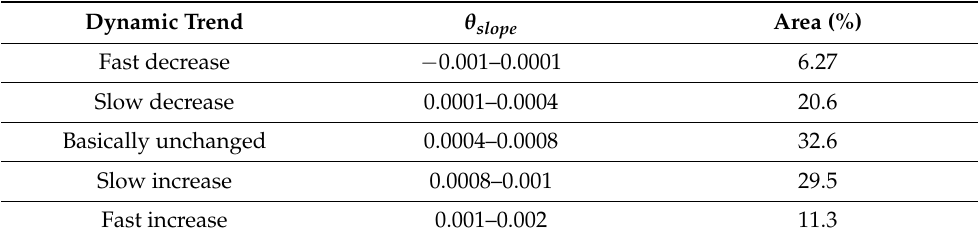
Table 1. The trend of NDVI from 2009 to